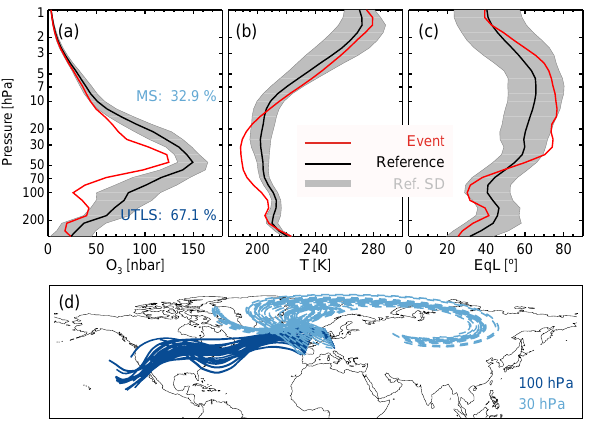
Figure 8. (a) MLS mean ozone vertical profile (red), reference ozone profile (black), and reference standard deviation (gray enve- lope) during the mini-hole event observed over the UK on 19 Jan- uary 2006. The reference profile was constructed using profiles over the mini-hole region from 15 days prior to 15 days after the event, excluding profiles under mini-hole event conditions. The percent- age ozone reduction with respect to the total column ozone in the UTLS and in the mid-stratosphere is shown in dark and light blue, respectively. (b) As in (a) but for temperature. (c)) As in (a) but for equivalent latitude (EqL) derived from the MERRA-2 reanalysis sampled at the MLS measurement locations. (d) MERRA-2 trajec- tories launched at the MLS measurement locations in the mini-hole event region at 100 and at